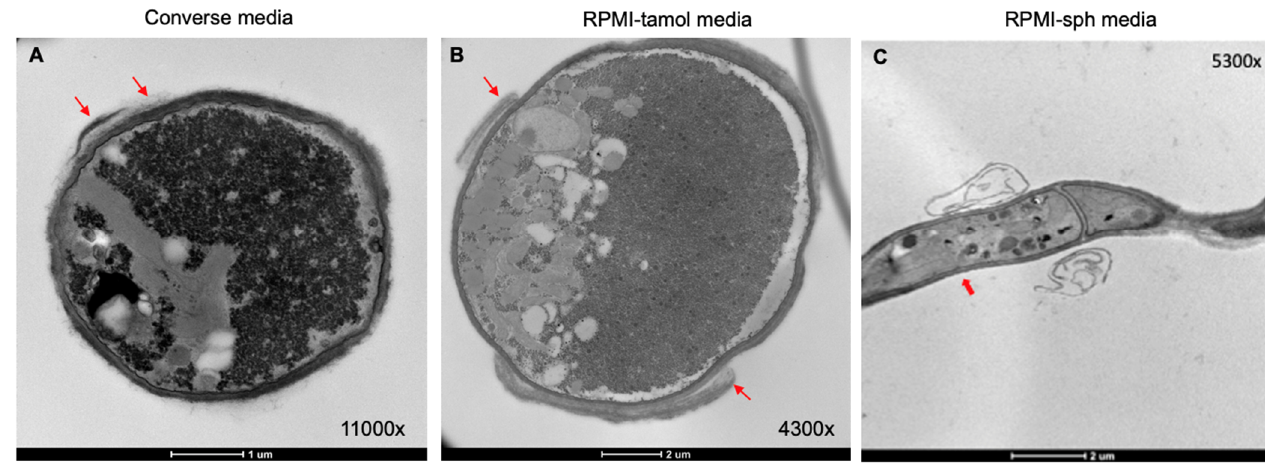
Figure 4. Ultrastructural features of C. posadasii S/E strain . TEM revealed a sloughing off of the outer cell wall glycoprotein layer of spherules (red arrows) grown in Converse ( A ) or RPMI-tamol media ( B ) that was not observed in the hyphal form (( C ), red arrow). Hyphae also appeared to lack endospores in comparison to spherules. TEM images of C. posadasii S/E grown in Converse, RPMI-tamol, or RPMI-sph media were taken after 168 h growth in vitro.